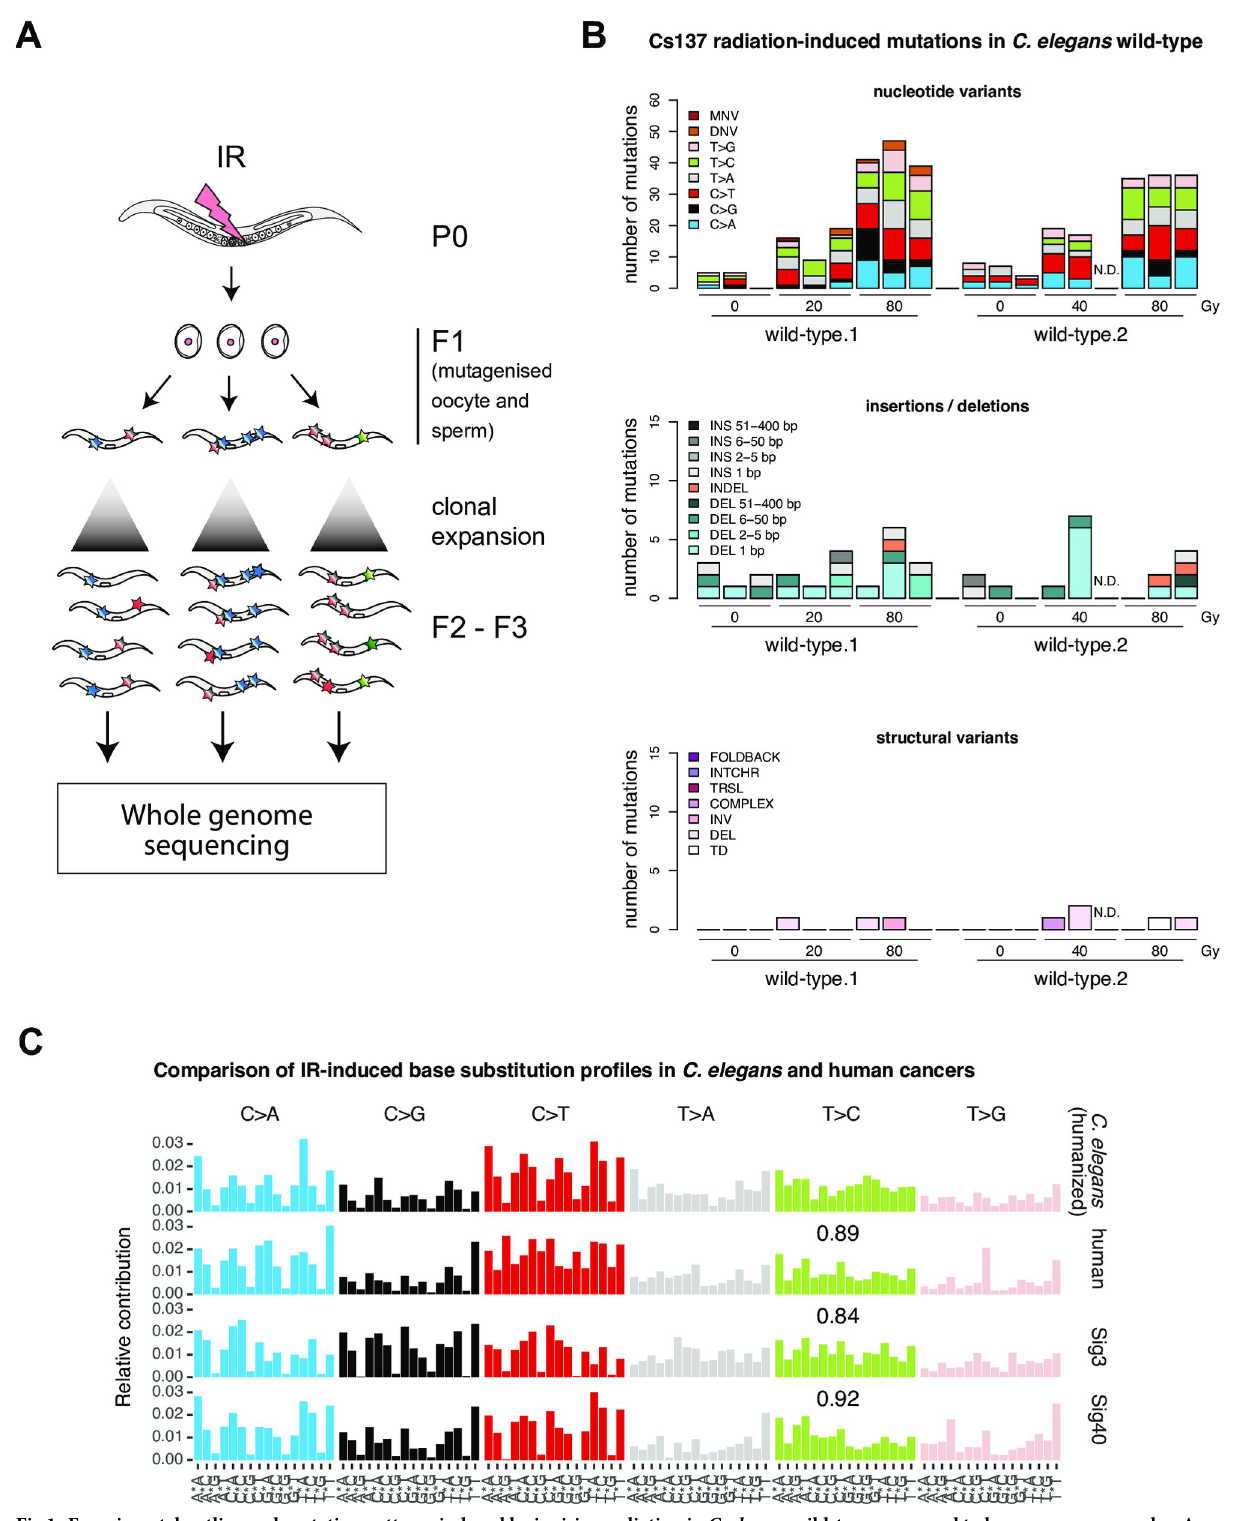
Fig 1. Experimental outline and mutation patterns induced by ionising radiation in C . elegans wild-type compared to human cancer samples. A. Experimental outline: Parental (P0) animals were exposed to a Cs137 radiation source at the L4 developmental stage. 3 times 3 P0 animals were allowed to lay eggs and two L4s of the first filial (F1) generation per P0 plate were individually transferred to new plates and allowed to clonally expand by self-